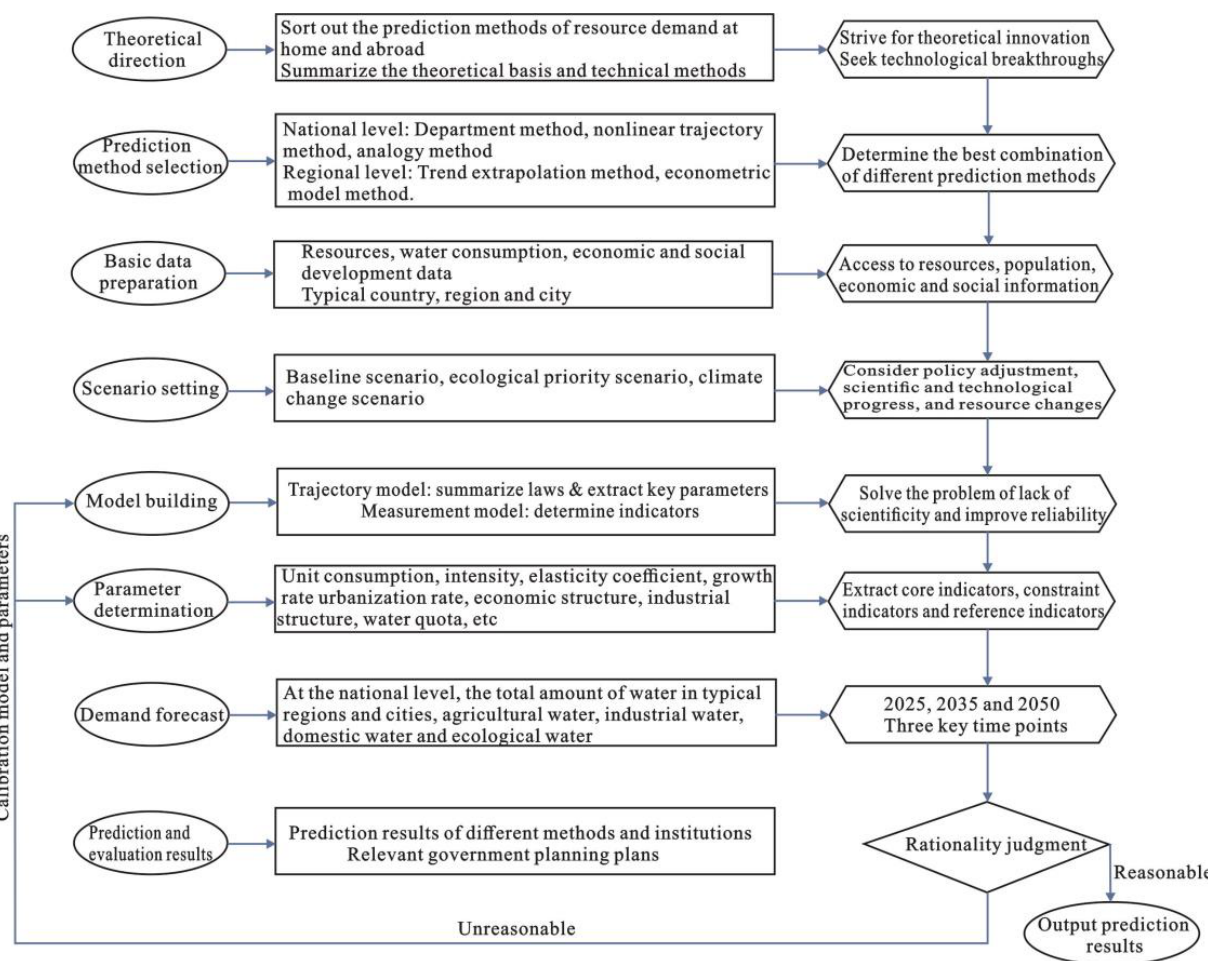
Figure 1. Technical route of water resource demand prediction.